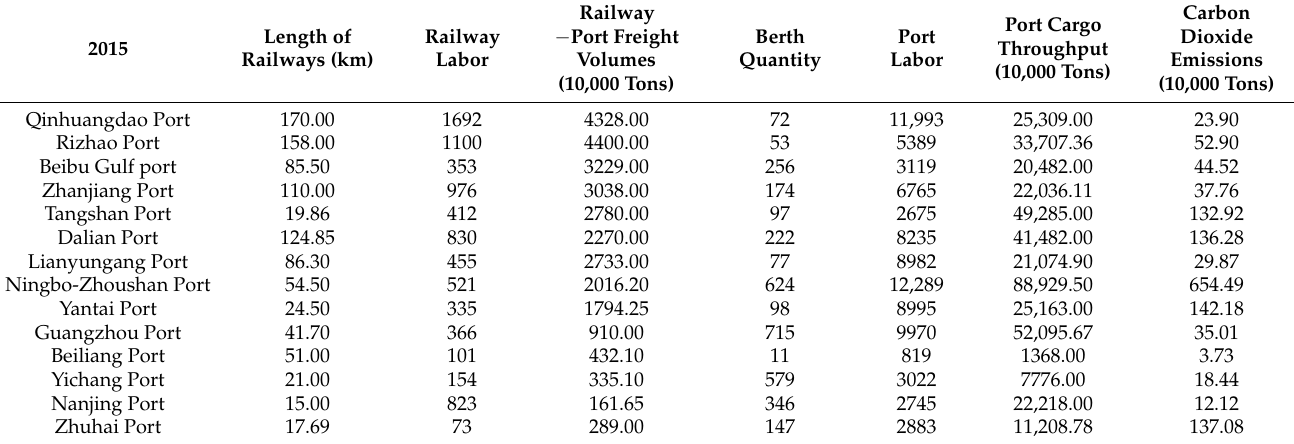
Table 3. Specific values of